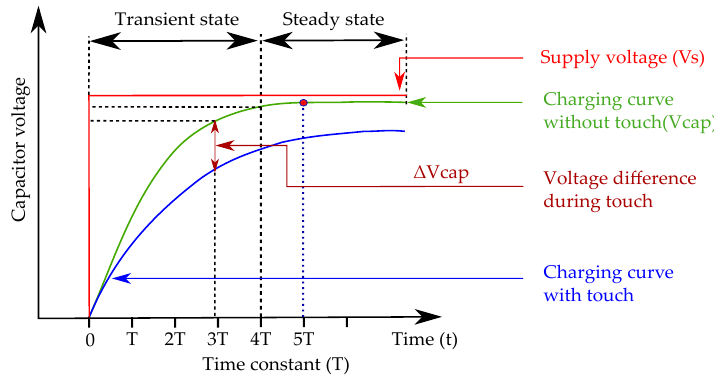
Figure 4. Capacitor charging curve with and without touch.